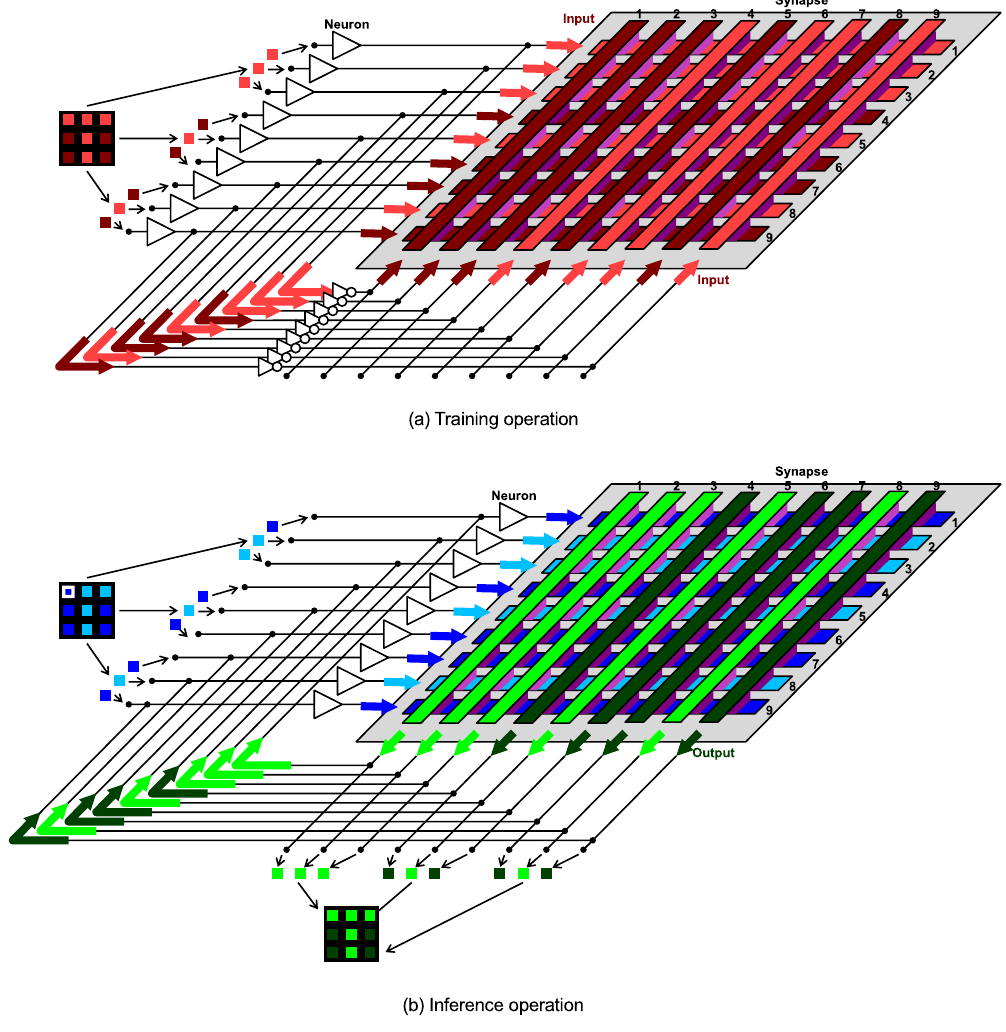
Figure 5. Neuromorphic operation. (a) Training operation. ( b ) Inference operation. During the training operation, the voltage that corresponds to the pattern to be memorized is applied to the bottom and top electrodes in the crossbar array. In ( a ), the bright purple at the cross points indicates that the electrical conductance increases, whereas the dark purple indicates that the electrical conductance is maintained. During the inference operation, the voltage that corresponds to the pattern slightly distorted from the memorized pattern is applied only to the bottom electrodes. Also in ( b ), the bright purple indicates that the electrical conductance increases, whereas the dark purple indicates that the electrical conductance is maintained. Consequently, some voltage is finally output after the transient behavior, which is a revised